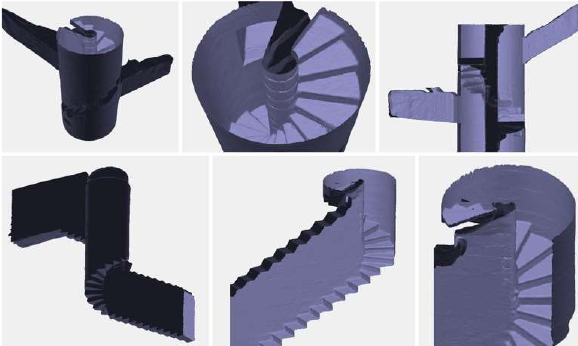
Figure 10. 3D view of portion of the mesh model produced from the acquisition of Path A